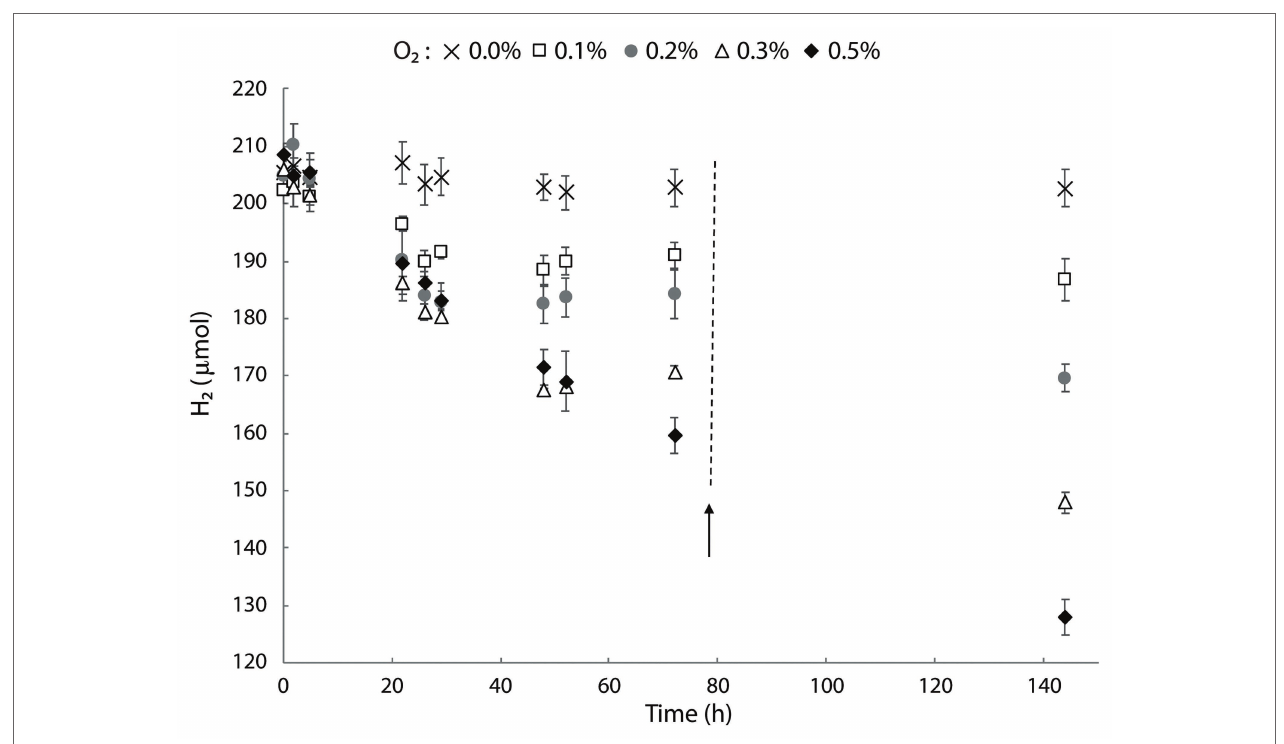
FIGURE 7 | Hydrogen consumption in M. thermophilum AP8 with different O 2 concentrations. Bottles were incubated with 0–0.5% O 2 and the activity followed for 144 h. The black arrow indicates the addition of O 2 to the initial concentration. Error bars represent the standard deviation over the average from three biological